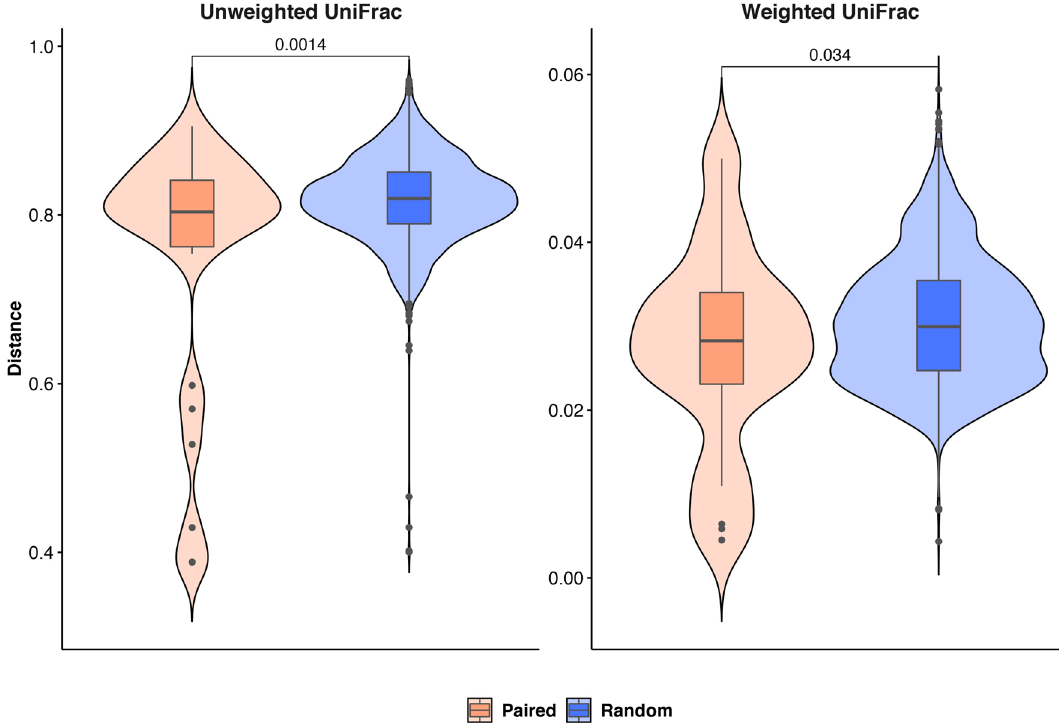
Figure 4. Violin plot showing the observed weighted and unweighted UniFrac distances among paired (i.e. samples belonging to the same individual but from different matrices) and random pairs. The resulting p-value is shown for both comparisons.